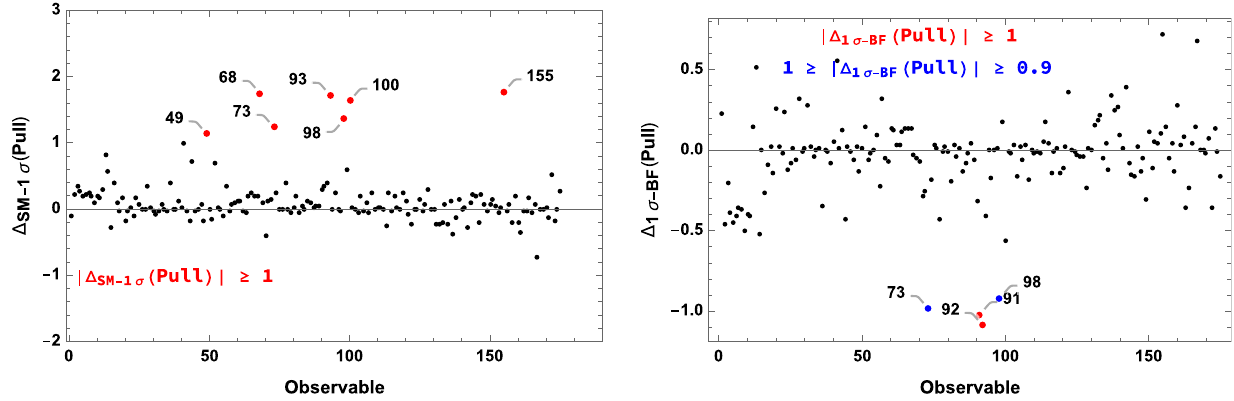
Fig. 5 Pull difference between the point along the BF-SM direction at 1 σ from the BF, and the SM (BF) in the left (right) panel